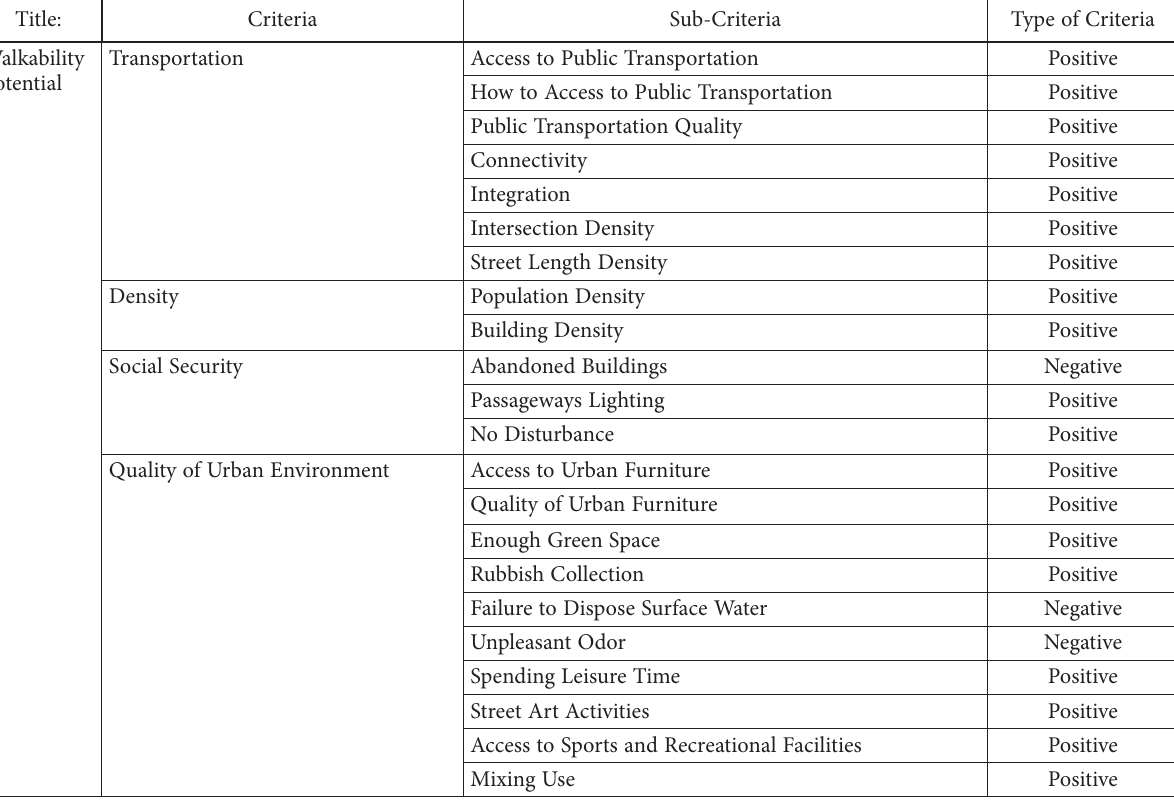
Table 1. Walkability criteria and sub-criteria (source: